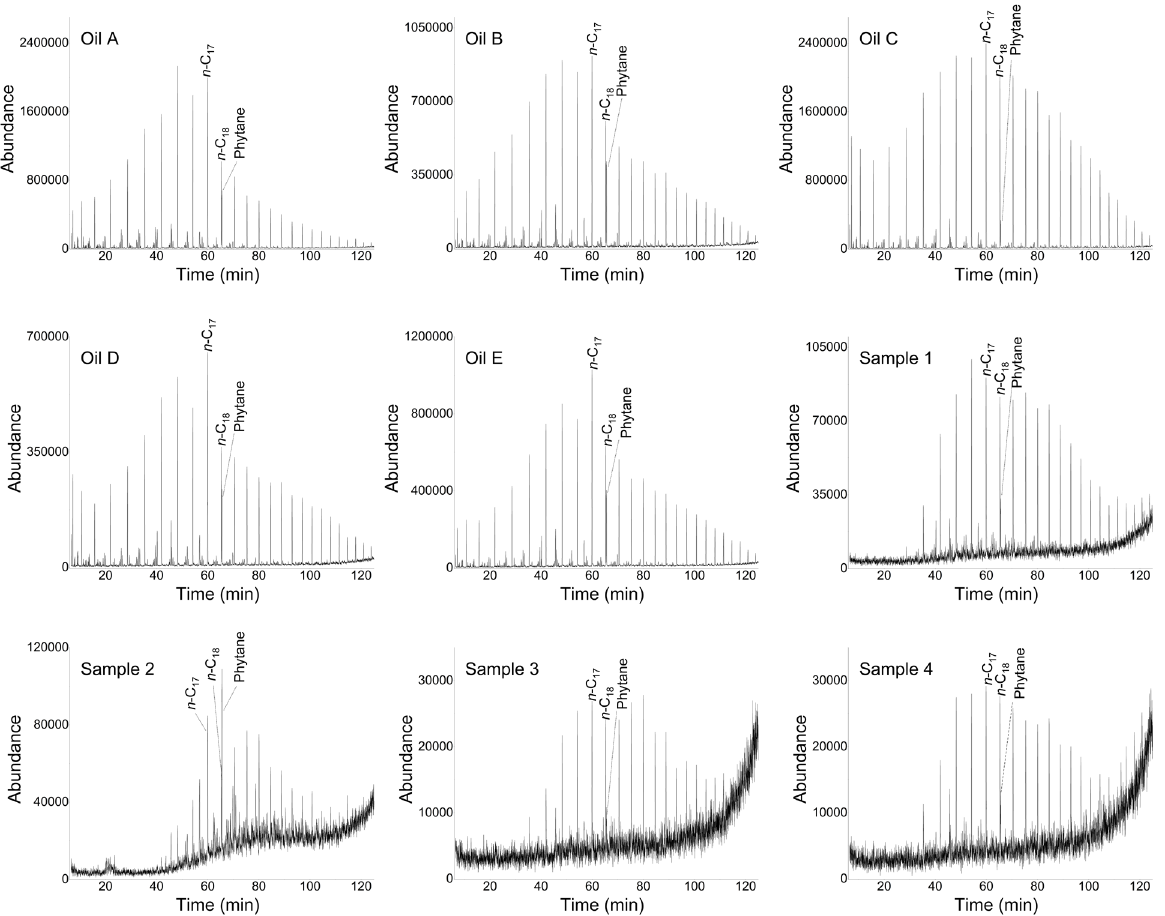
Figure 2. Reconstructed m/z 85 ion chromatograms for evaluation of n-alkanes distribution